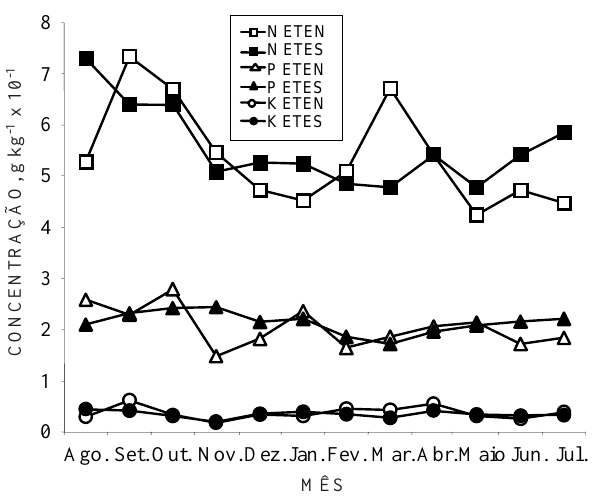
Figura 1. Variação na concentração de N, P e K no biossólido das ETEs Norte e Sul.